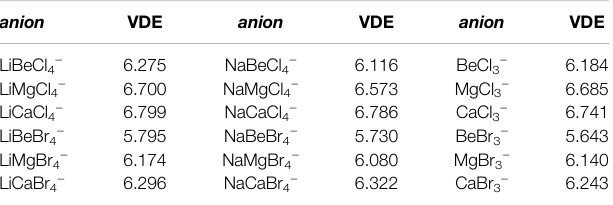
TABLE 3 | The largest vertical detachment energies VDE (eV) of superhalogen anions MM ′ X 4 − (M = Li, Na; M ′ = Be, Mg, Ca, X = Cl, Br) and M ′ X 3 − (M ′ = Be, Mg, Ca, X = Cl, Br).